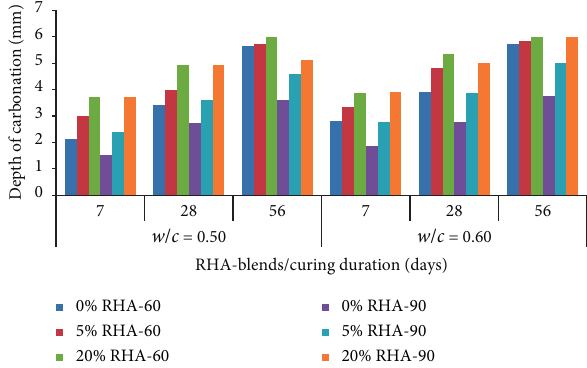
Figure 6: Depth of carbonation at different curing periods verses